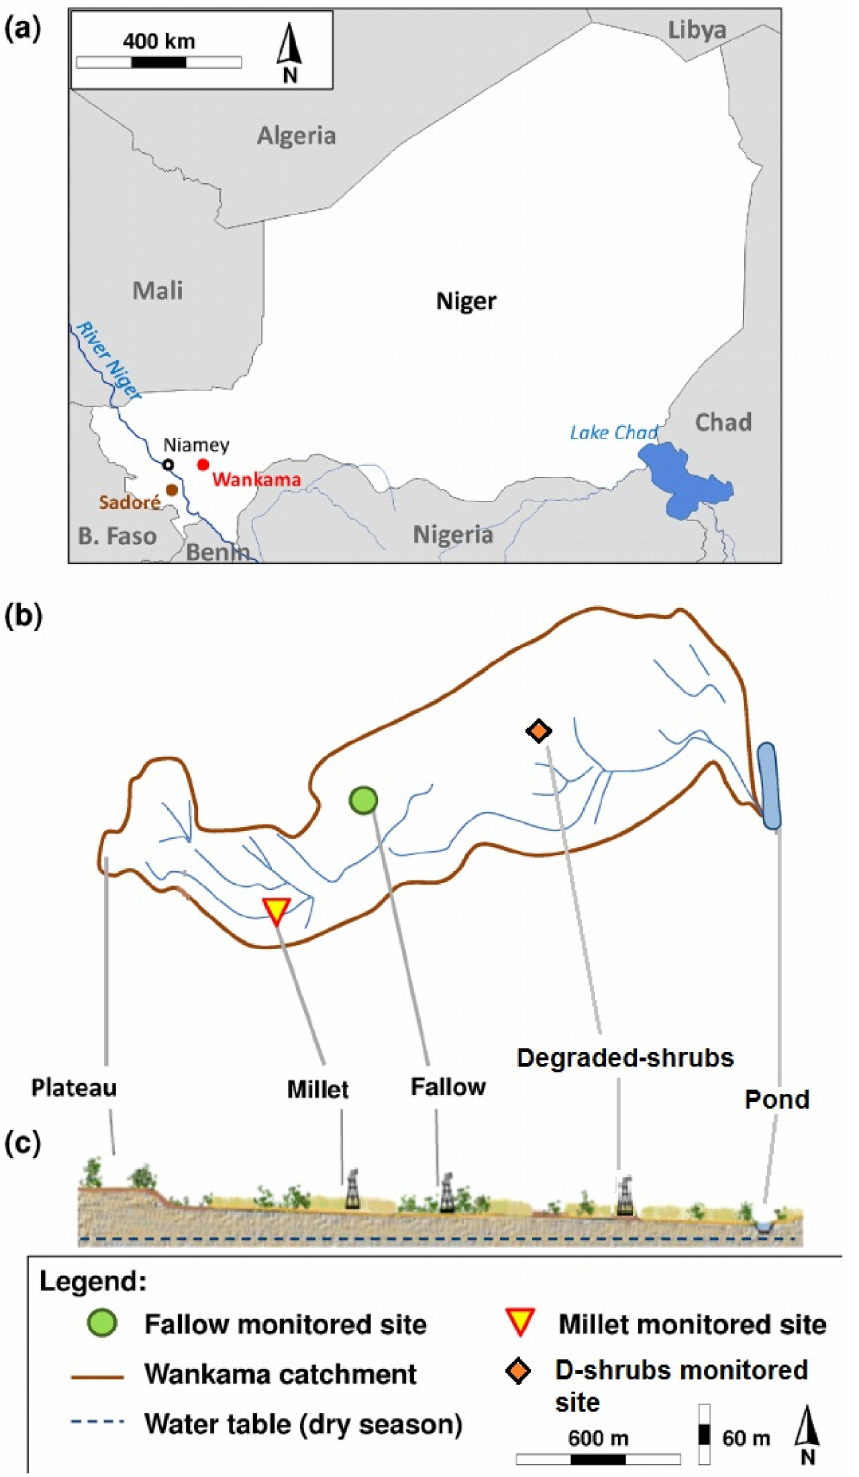
Figure 1. ( a ) Map of the Wankama basin; ( b ) location of the three study sites (millet, fallow and degraded shrubs); and ( c ) basin toposequence